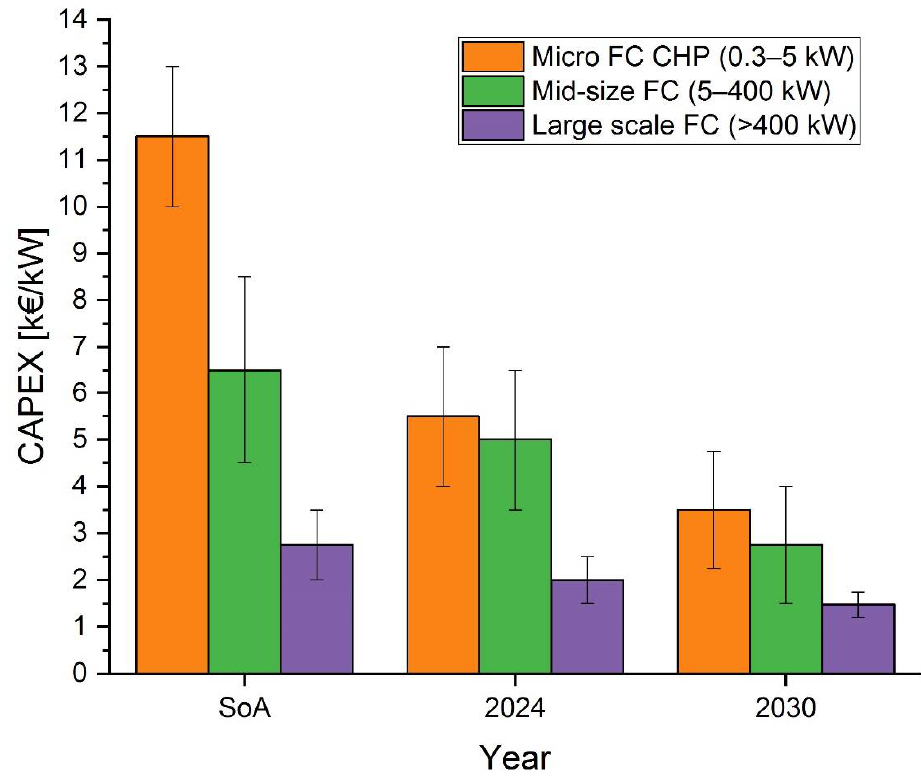
Figure 8. Fuel cell capital expenditure forecast.